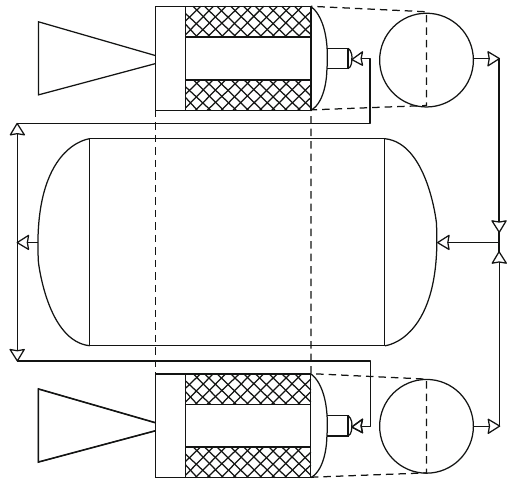
Figure 8: Con fi guration of 3rd-stage